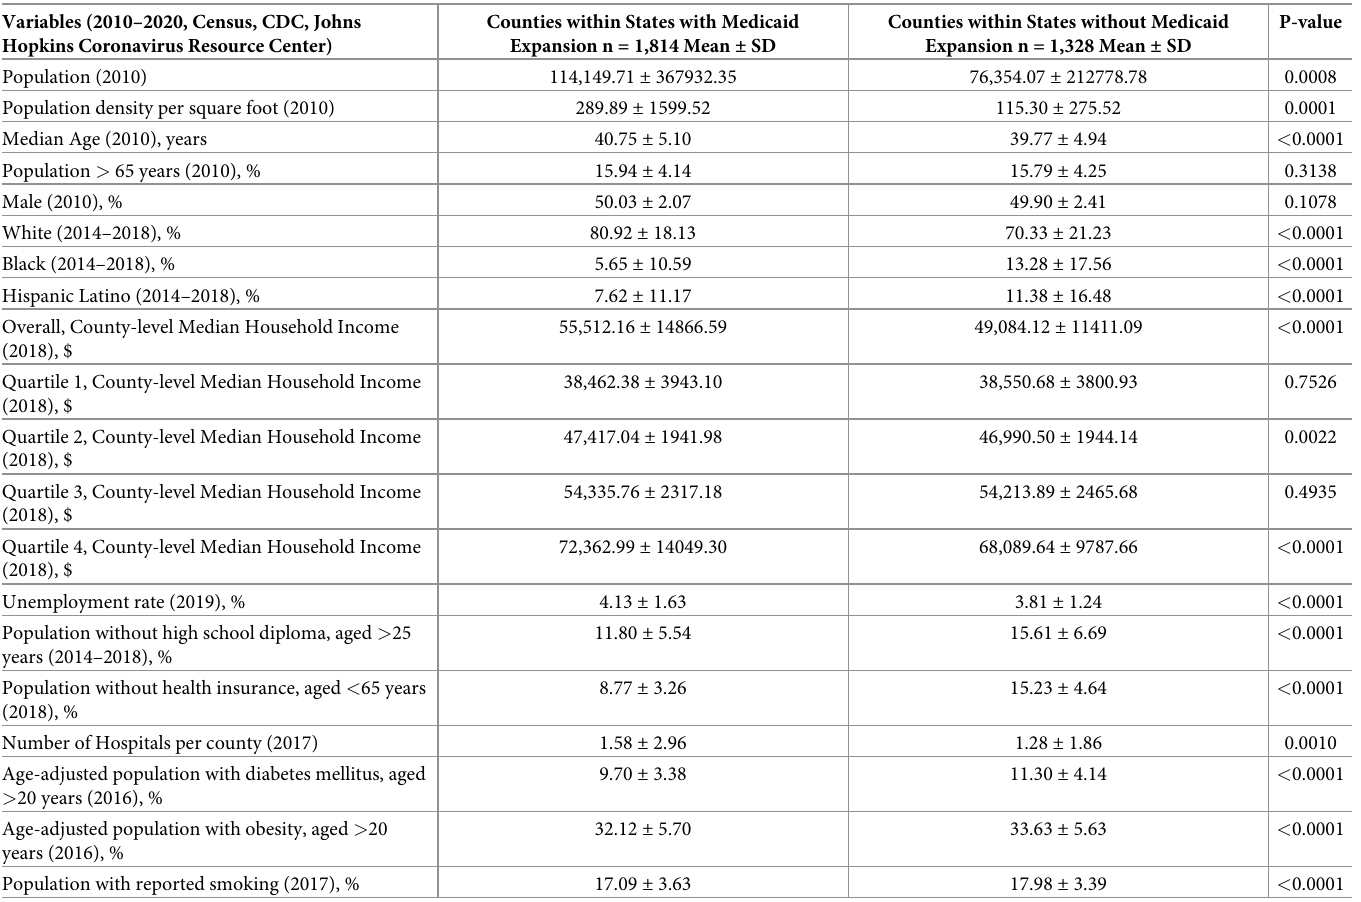
Table 3. Counties baseline characteristics by Medicaid expansion status of the